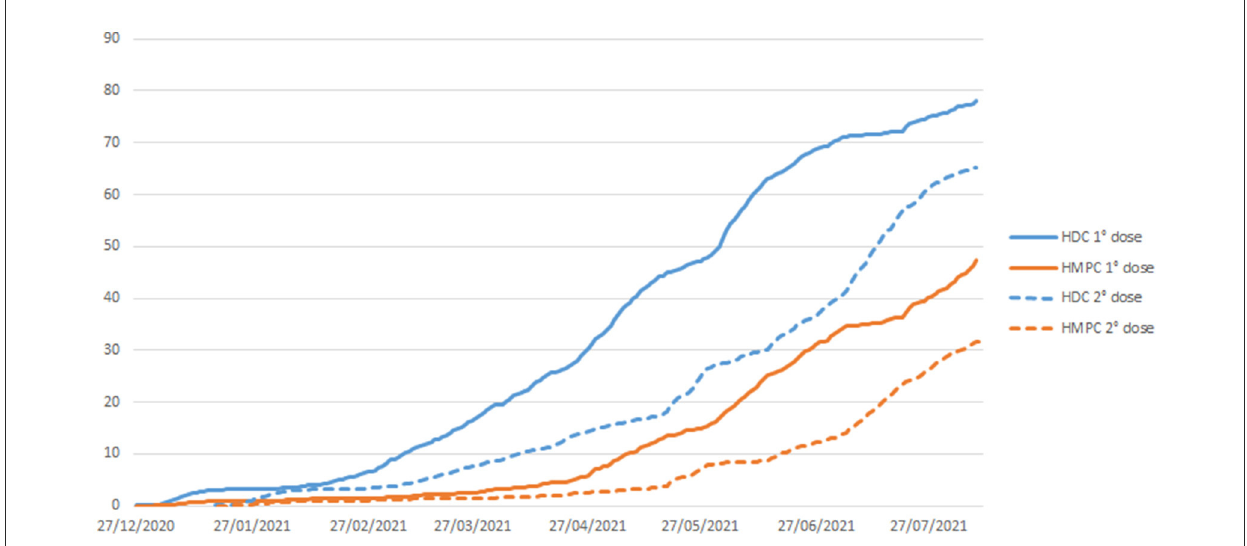
FIGURE3 Direct acyclic graph (DAG) of the relationship between ethnicity and diabetes and COVID-19-related death, in which the effect modifier is ethnicity, the exposures are obesity and diabetes, and the outcome is COVID-19-related